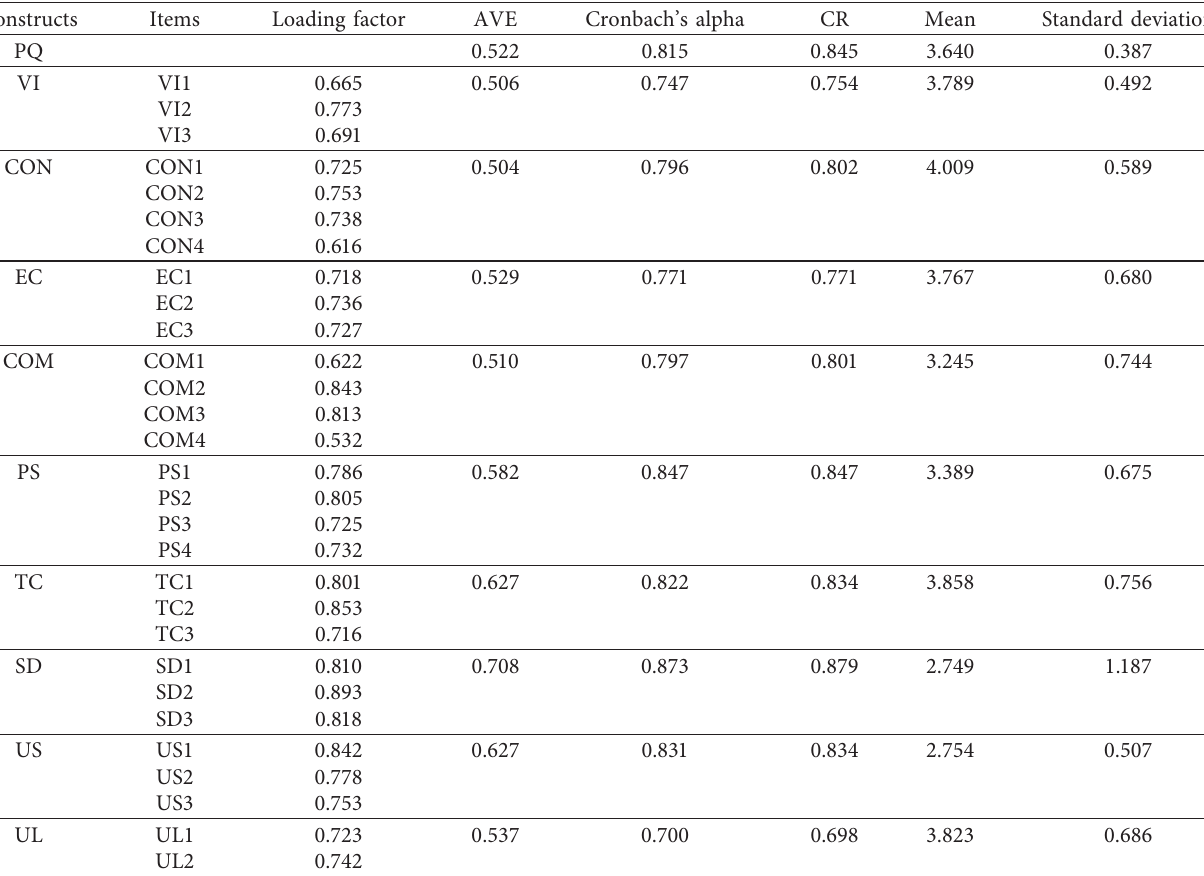
Table 5: Construct loading factors, CA coefficients, CR values, and AVEs.